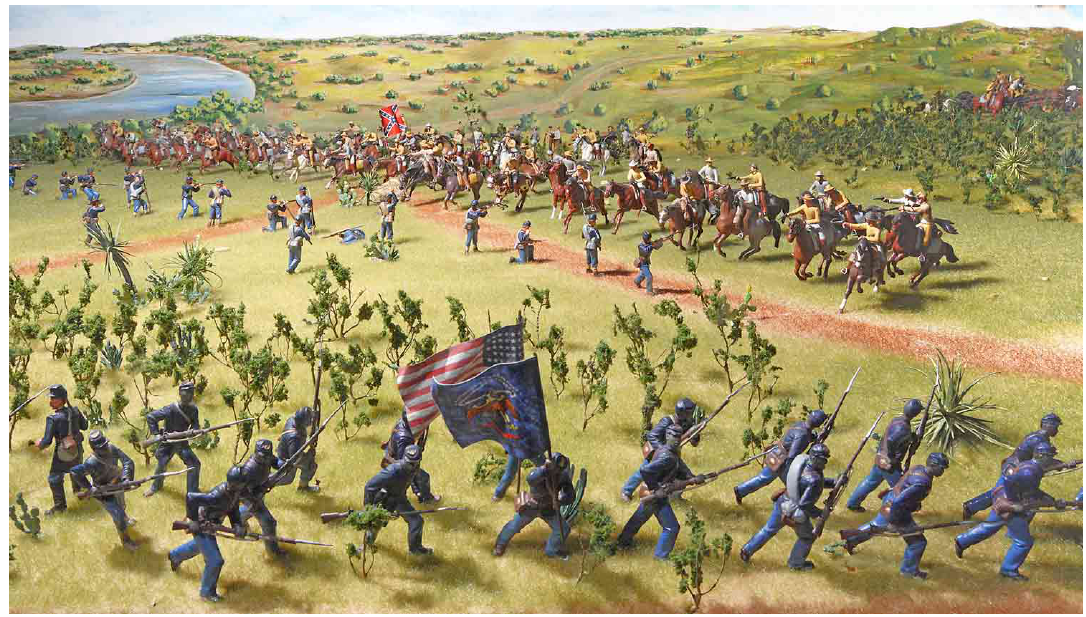
Figure 1. Confederate cavalry and Union troops readying for battle (Texas Military Forces Museum)